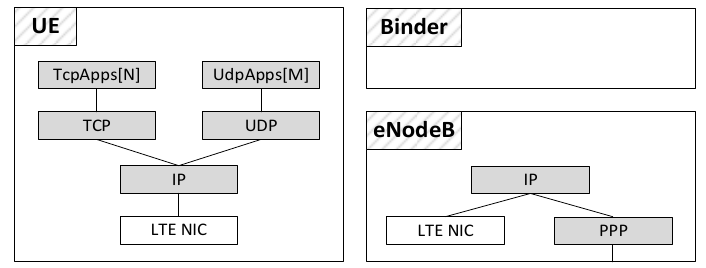
Figure 3. System overview of the radio-access network (grey: INET modules; white: SimuLTE modules).